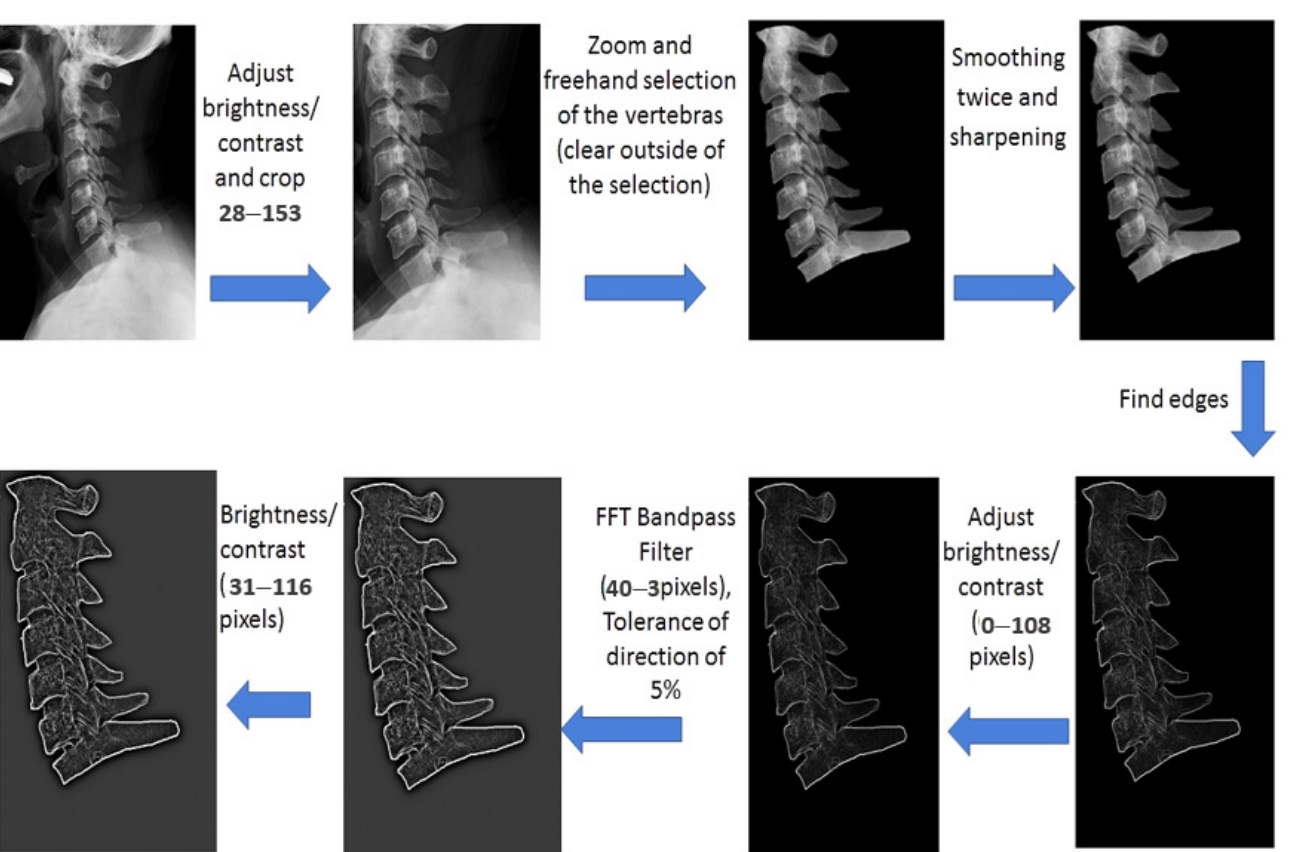
Figure 3. Features extraction using the GLCM method applied to the neck’s X-ray images.